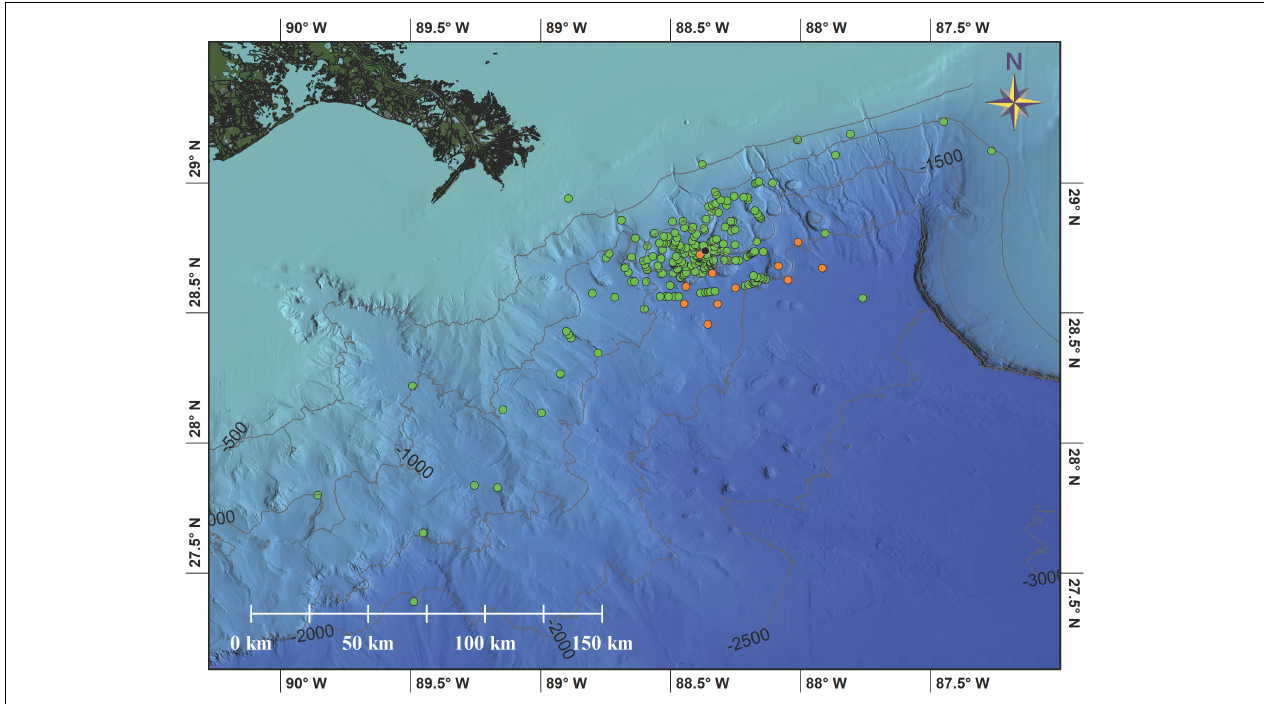
FIGURE 1 | Location of studied sites in the nGoM where sediment cores were collected between 2010 and 2011 (green circles; ERMA and Gulf Science publicly available data) and 2018 (orange circles; REDIRECT project). The Deepwater Horizon wellhead is shown as a black